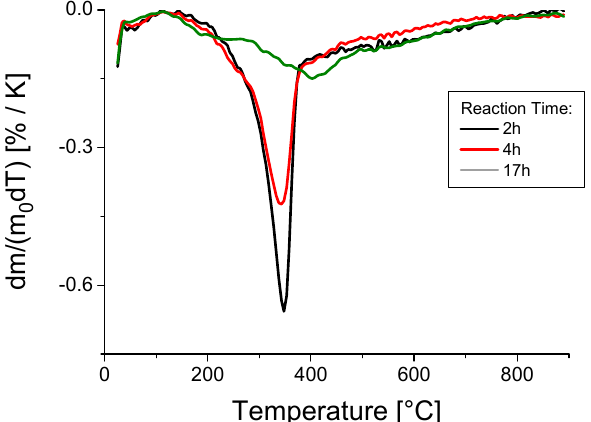
Figure 5. DTG of hydrochar from beach chips (10% dry mass, 220 °C), produced with different reaction times, modified from [21].